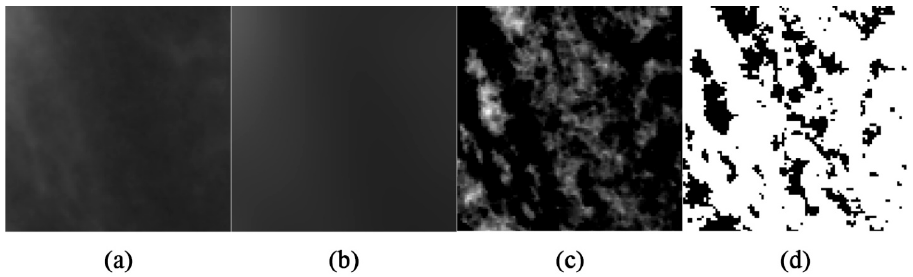
Figure 3. ROIs after the ( a ) clear outside, ( b ) Gaussian blur, ( c ) subtracting, and ( d ) make binary